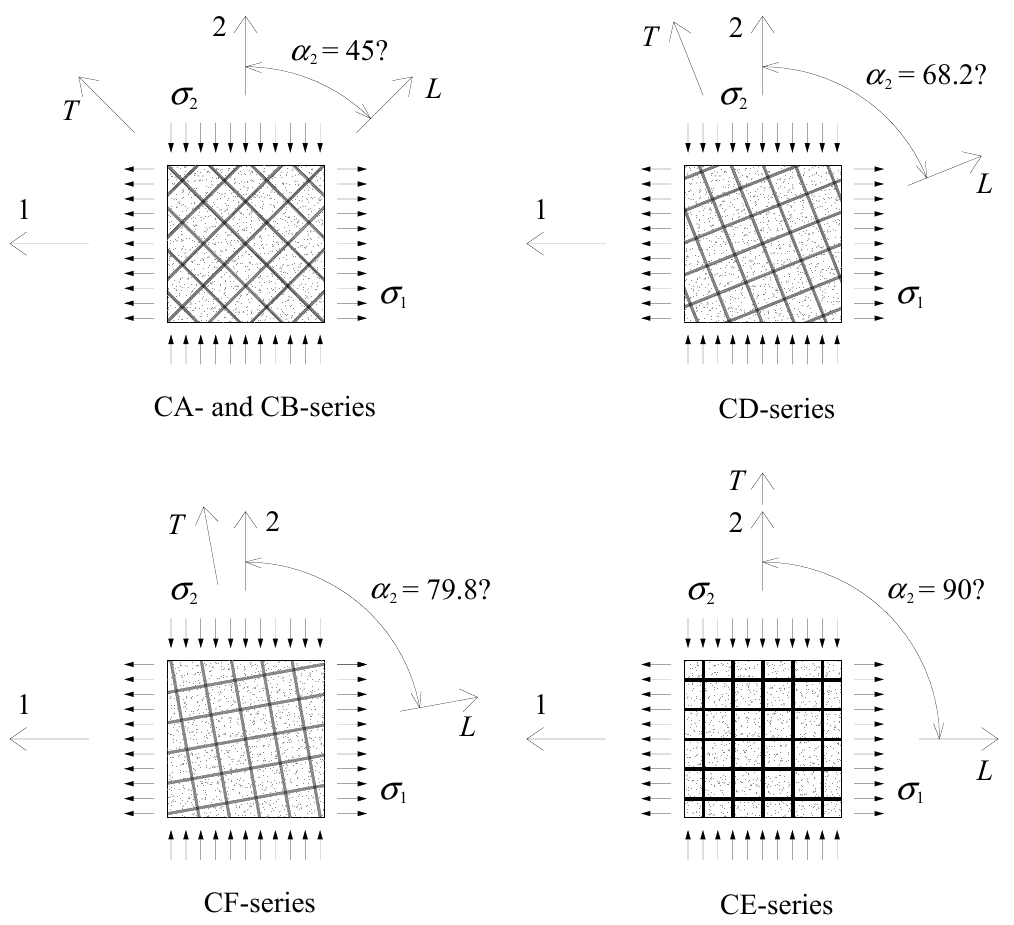
Figure 5. Loading condition and reinforcement layout of the reference RC panels.